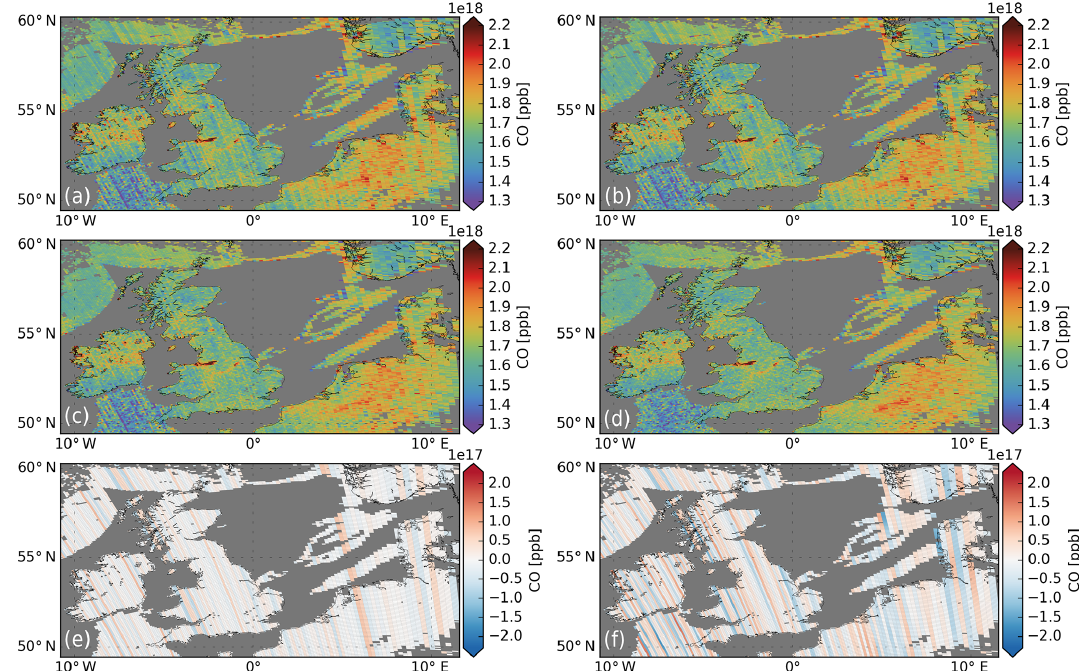
Figure 7. CO retrievals of a TROPOMI orbit granule on 27 June 2018 over the UK. Panels (a, b) depict the original data, panels (c, d) show the destriped TROPOMI CO data ( c FMD method, d FFD method) and panels (e, f) illustrate the destriping mask that was subtracted from the original TROPOMI data.